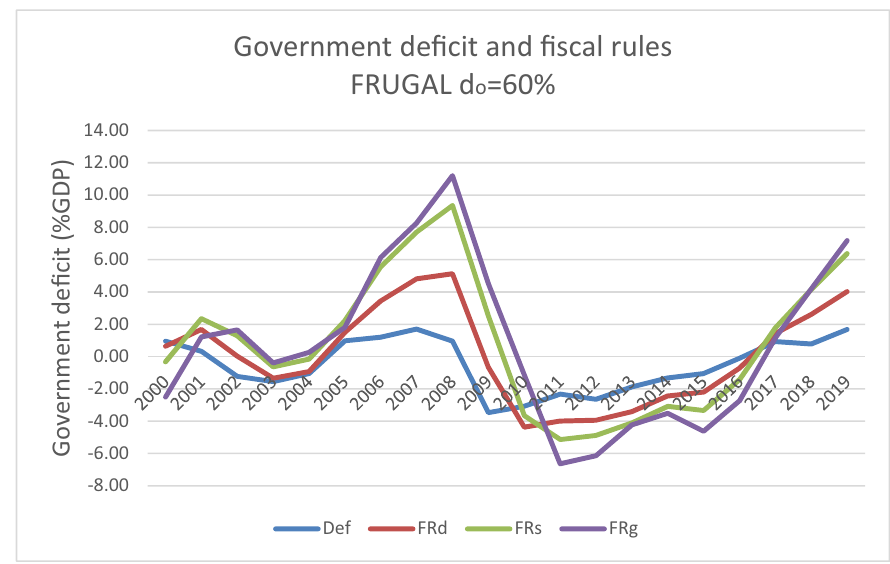
Figure 2.8: Frugal countries government de fi cit ( Source: Own elaboration from data on Table 2 ) .